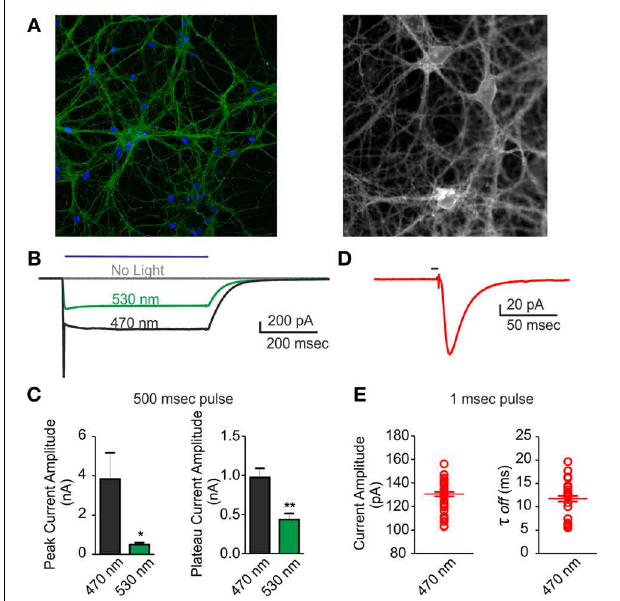
FIGURE 2 | Voltage-clamp characterization of ChR2/H134R-expressing neurons. An inward current could be triggered by illumination with the 470nm LED in neurons infected with ChR2/H134R. (A) (Left) Confocal image of 18 div neurons infected with ChR2/H134R-YFP labeled with DAPI (blue) and anti-GFP (green) and ( right ) live imaging of infected neurons at 18 div during electrophysiological recordings (fluorescent signal: ChR2-YFP). (B) Representative traces of inward currents induced by a 500ms light pulse at either 470 (black) or 530nm (green) wavelength or without illumination (gray). (C) Mean ( ± s.e.m.) peak amplitude and plateau amplitude of inward current induced by a 500ms light pulse at 470 or 530nm ( n = 6). (D) Representative trace of an inward current induced by 1ms light pulse at 470nm. (E) Mean ( ± s.e.m.) current amplitude and decay ( τ off ) of inward current induced by 1ms light pulse at 470nm ( n = 45 from 6 independent experiments). The individual data are also shown in the plot. ∗ p < 0 . 05; ∗∗ p < 0 . 001 Mann–Whitney test vs. 470nm.